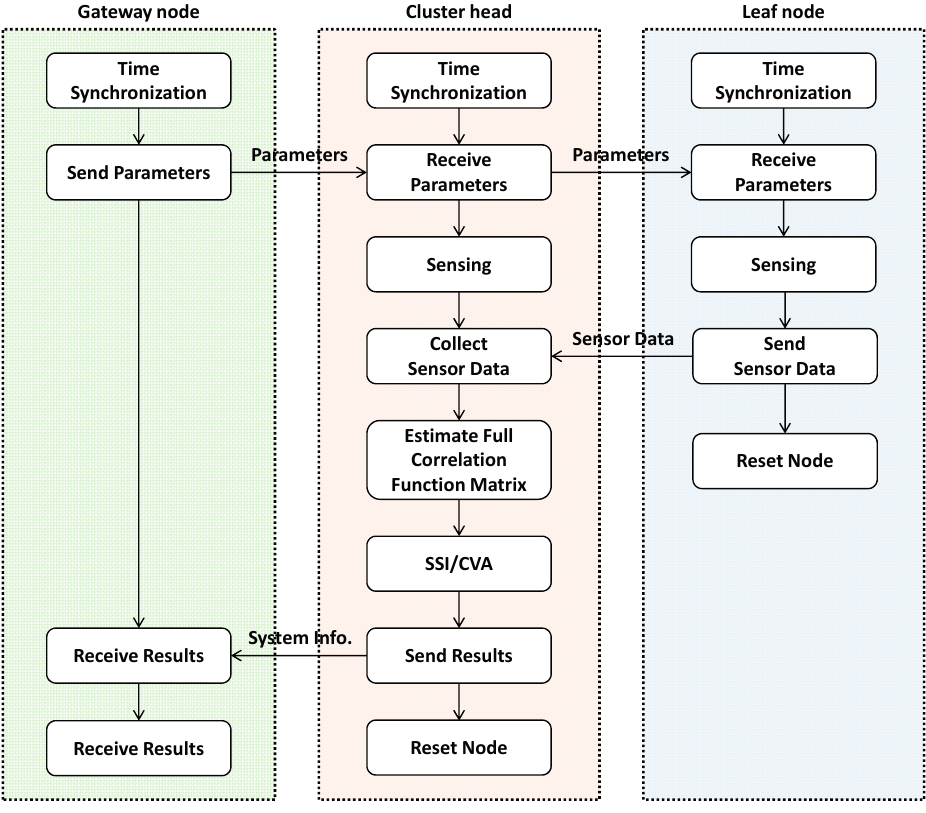
Figure 4. Flowchart of